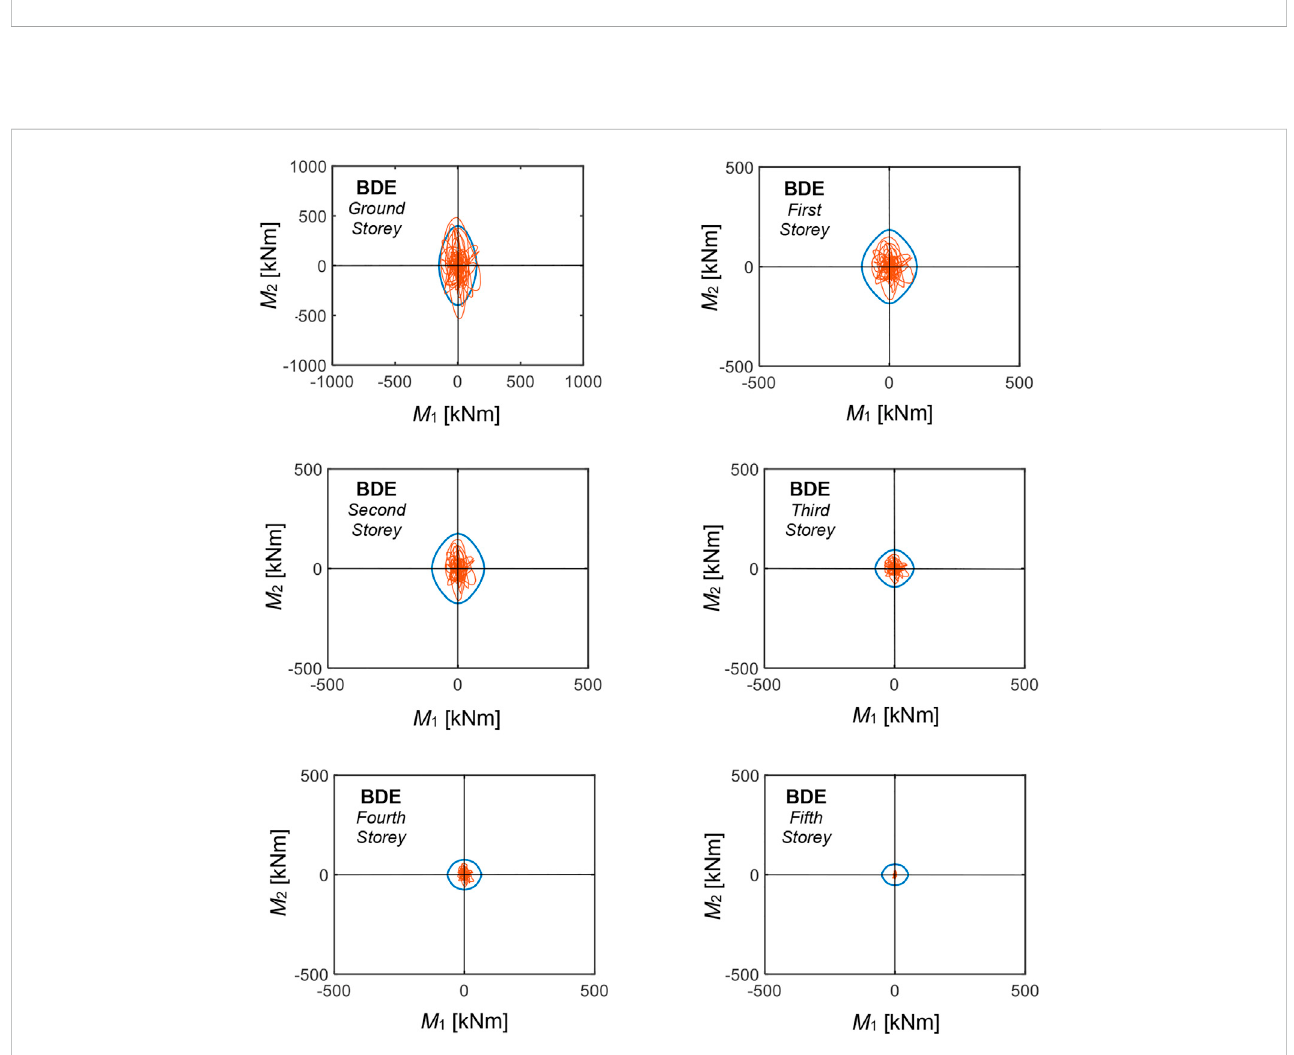
FIGURE 10 M 1 – M 2 biaxial moment interaction curves (red lines) for the columns belonging to the 3/B vertical fi xed line obtained from the most demanding BDE- scaled group of input accelerograms in retro fi tted conditions, and relevant safe domains (blue lines).